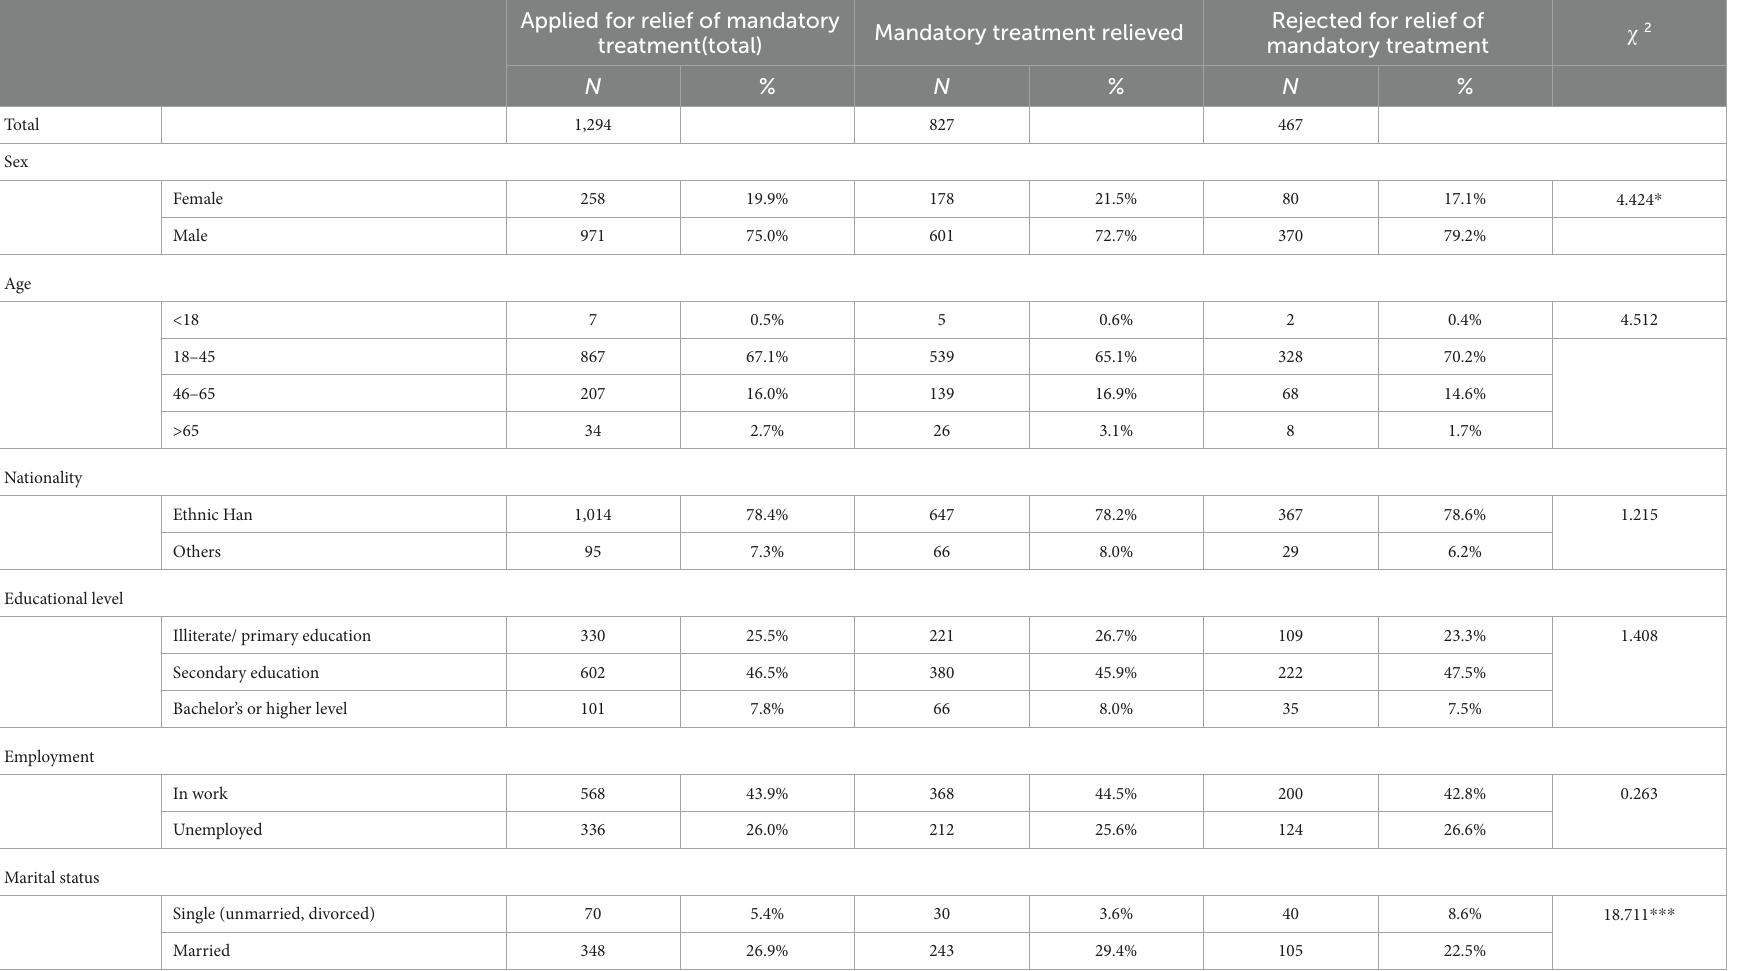
TABLE 2 Descriptive characteristics of mentally ill offenders for whom relief of mandatory treatment applications were made ( N = 1,294).